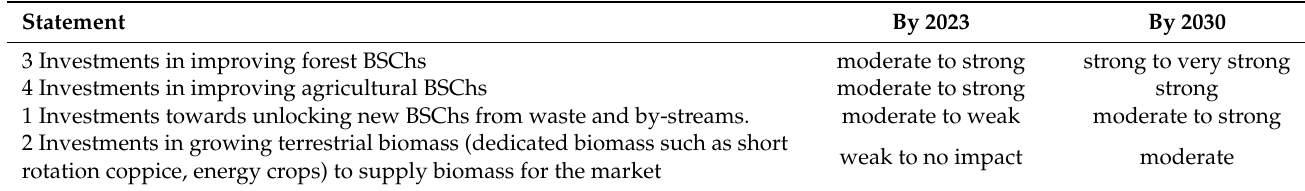
Table 6. Aggregated experts’ consensus on the impacts of the investments in different BSChs to the economic growth, across different scenarios.